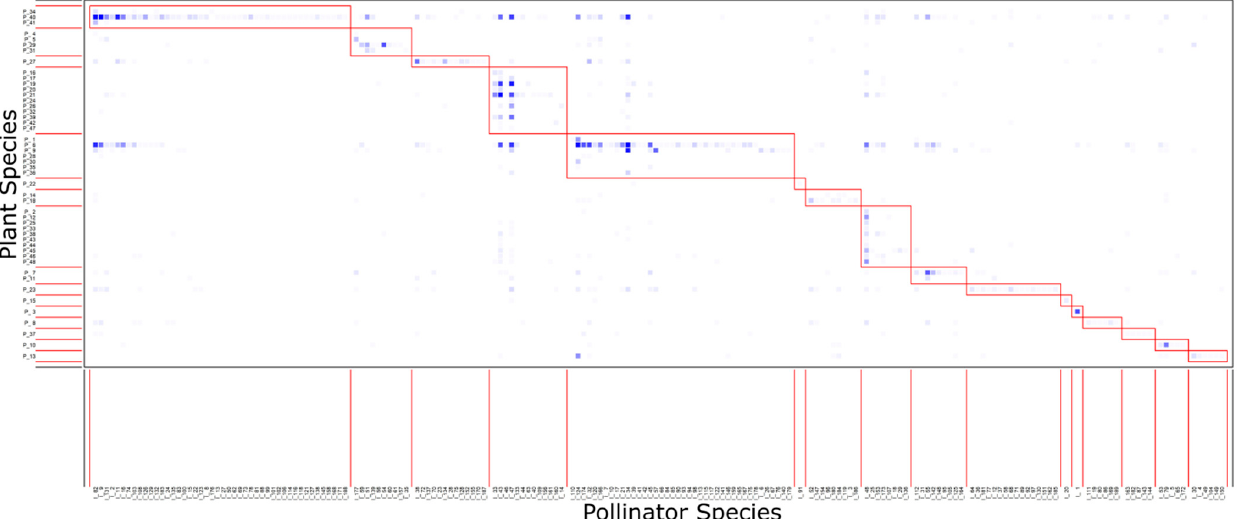
Figure 4. Modular network with 16 different modules. Species are sorted according to their modular affinity, plants as rows and pollinators as columns. Darkers squares indicate more interactions. OSR is in the fifth module. Species names are listed in Tables S4 and S5.